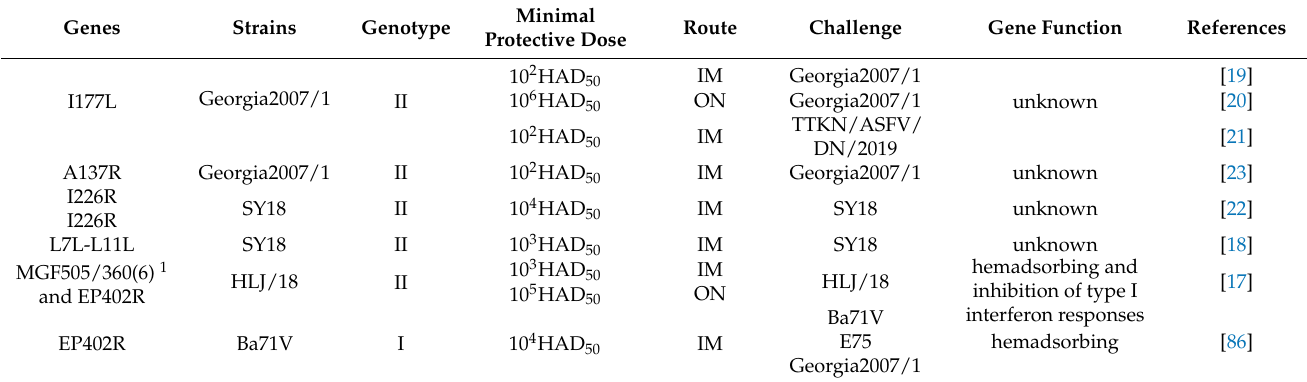
Table 1. Summary of the most promising LAV